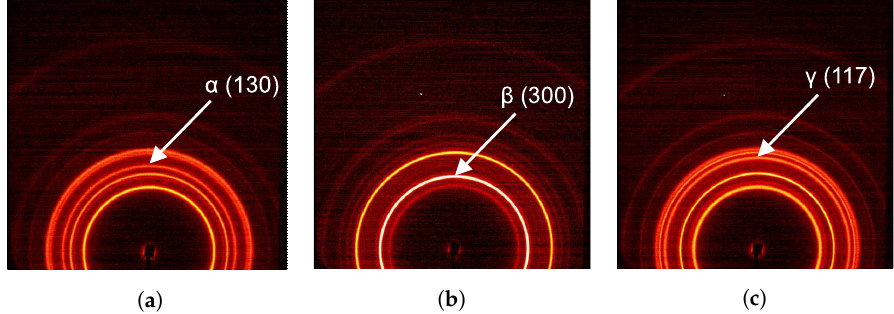
Figure 4. 2D WAXD patterns of iPP, characteristic for ( a ) α -iPP; ( b ) β -iPP and ( c ) γ -iPP, as prepared for this study . The diffraction peak unique for α -iPP is the third clear one going from the center towards outside of the pattern. The same holds for γ -iPP, whereas the diffraction ringspecific for β -iPP is the most clear one in the β pattern. All characteristic peaks are indicated in the